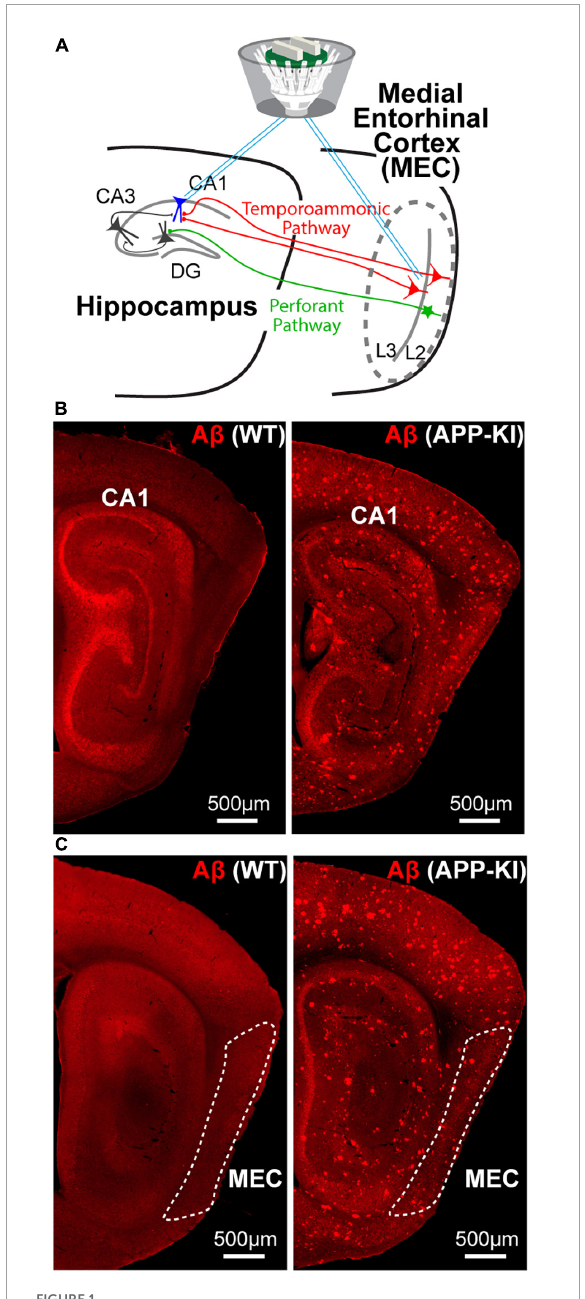
FIGURE1 Simultaneous SWR recording from the MEC and hippocampus CA1 of young APP-KI mice. (A) A schematic of simultaneous SWR recording from medial entorhinal cortex (MEC) layer 2/3 and CA1 of the hippocampus. (B,C) Sagittal sections with anti-A β immunostaining for 3 mo WT mouse (left) and 3 mo APP-KI mouse